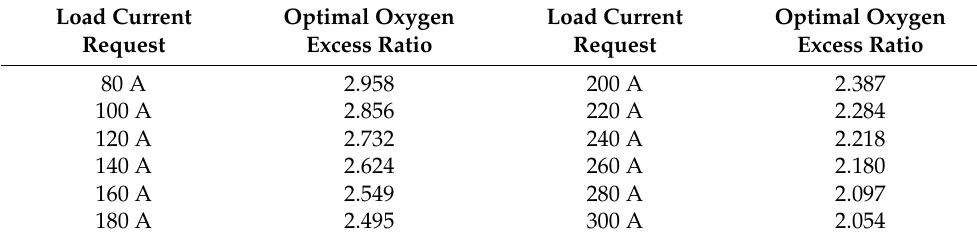
Table 2. Optimal oxygen excess ratio parameters of the PEMFC system.